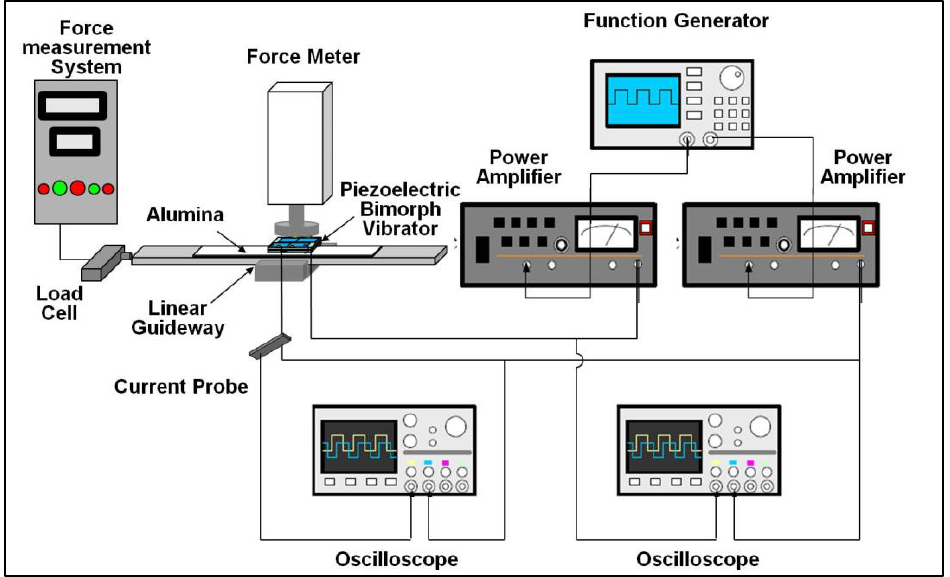
Figure 12. USM performance measurement system.